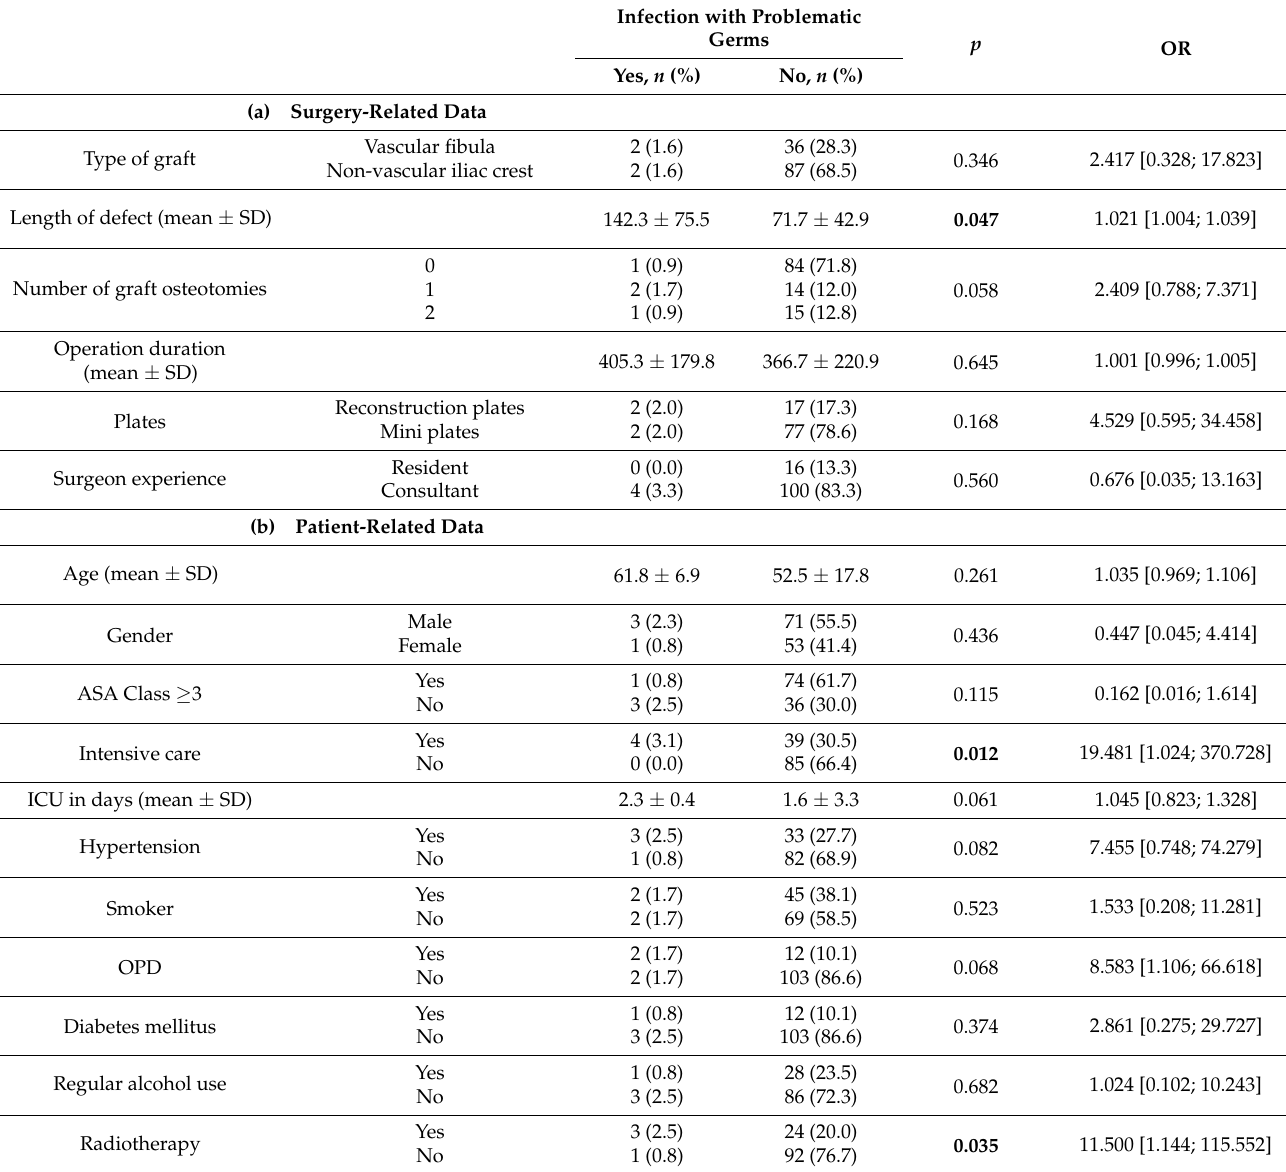
Table 10. Univariate Analysis of Risk Factors on Infection with problematic germs.